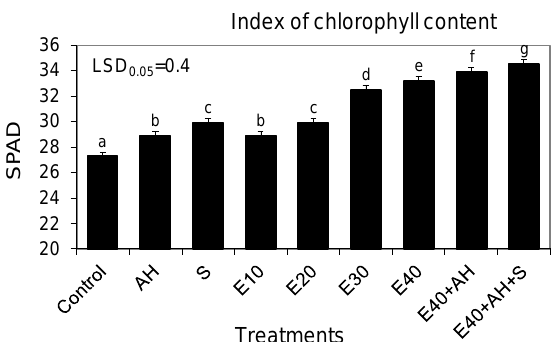
Figure 4. Index of the chlorophyll content in leaves of the Jerusalem artichoke plants cultivated in a field and fertilized with liquid non-centrifuged waste from corn grain digestion to methane (E10, 40 m 3 ha − 1 ), Apol-humus (AH; 10 L ha − 1 ), and Stymjod (S; 5 L ha − 1 ). The data marked with the same letters are not significantly different, according to a Newman–Keuls multiple range test at an alpha level of 0.05. The data presented are the average over the years and 10 plants in each repetition of a particular experimental variant.